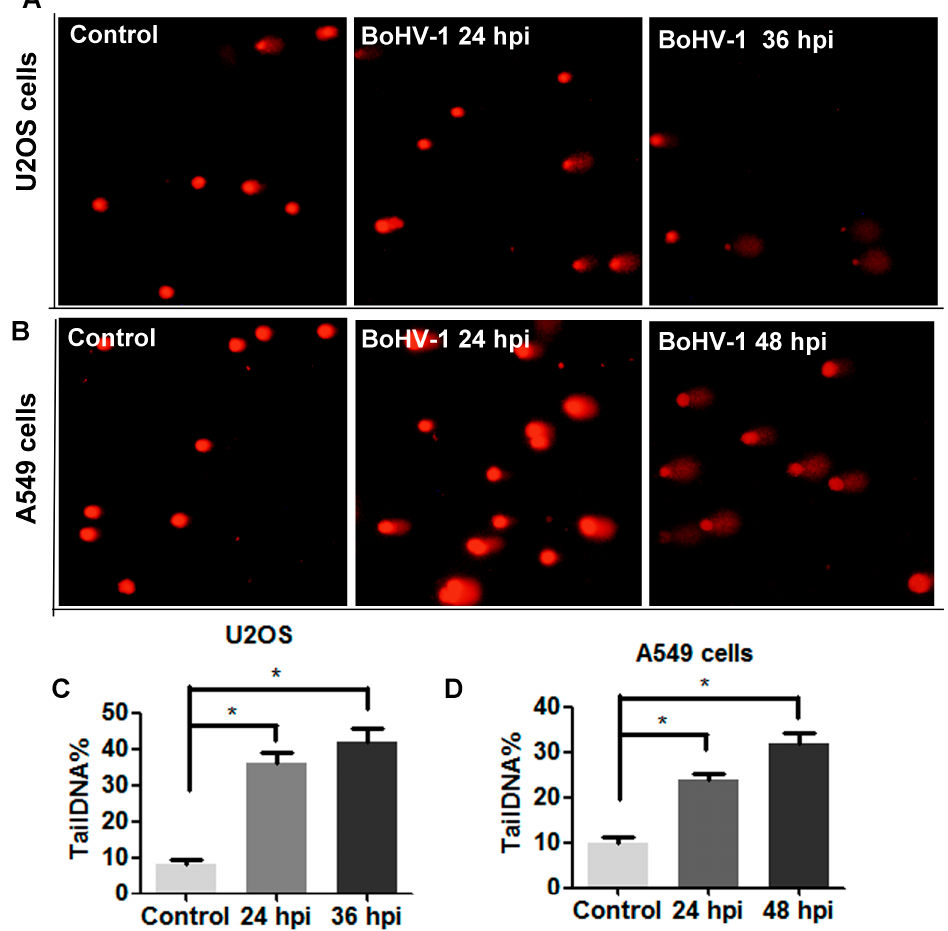
Figure 5. The detection of DNA damage in BoHV-1 infected human tumor cells. ( A , B ) Both U2OS cells ( A ) and A549 cells ( B ) were infected with BoHV-1 (MOI = 0.1) for designated times. The cells were collected and subjected to comet assay. Images shown were represents of three independent experiments (Magnification × 200). ( C , D ) Three hundred cells from either U2OS cells ( C ) or A549 cells ( D ) were randomly selected and calculated tailDNA% with software CASP. Values represented three independent experiments. (*, P < 0.05), significant differences was determined by a Student t